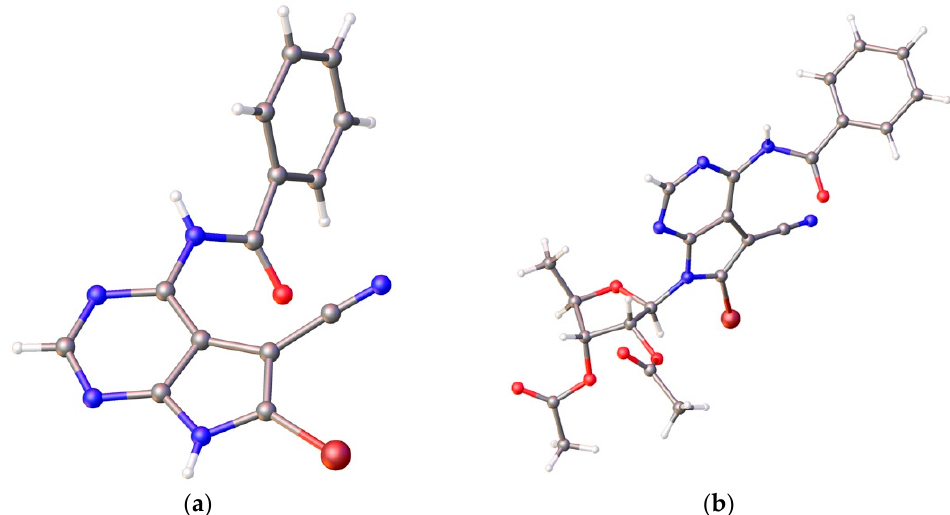
Figure 3. X-Ray structure of nucleobase 12 ( a ) and nucleoside 14 ( b ).